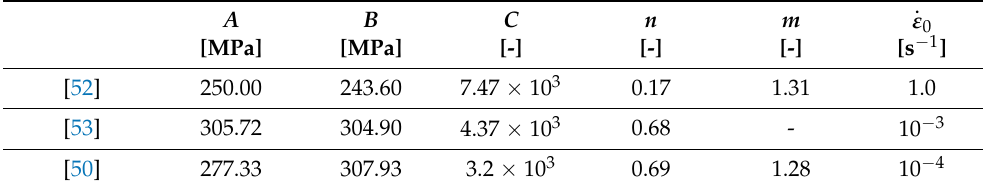
Table 2. Material parameters for the JC model for EN-AW-6082 T6 from literature sources. A B [MPa]